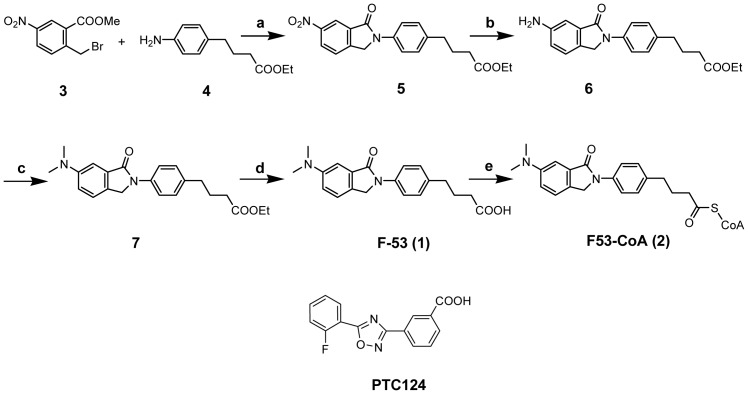
Chemical synthesis of F-53 (1) and its CoA conjugate (2), and the structure of PTC124.Conditions: a) pyridine, EtOH, reflux, 24 h, 62.3%; b) H2, 10% Pd-C, benzene, RT, 93.6%; c) HCHOaq., NaBH3CN, AcOH, THF, RT, 7.5 h, 88.4%; d) NaOH aq., EtOH, RT, 10 h, 77.6%; e) 3LiCoASH, PyBOP, K2CO3, THF, RT, 50%